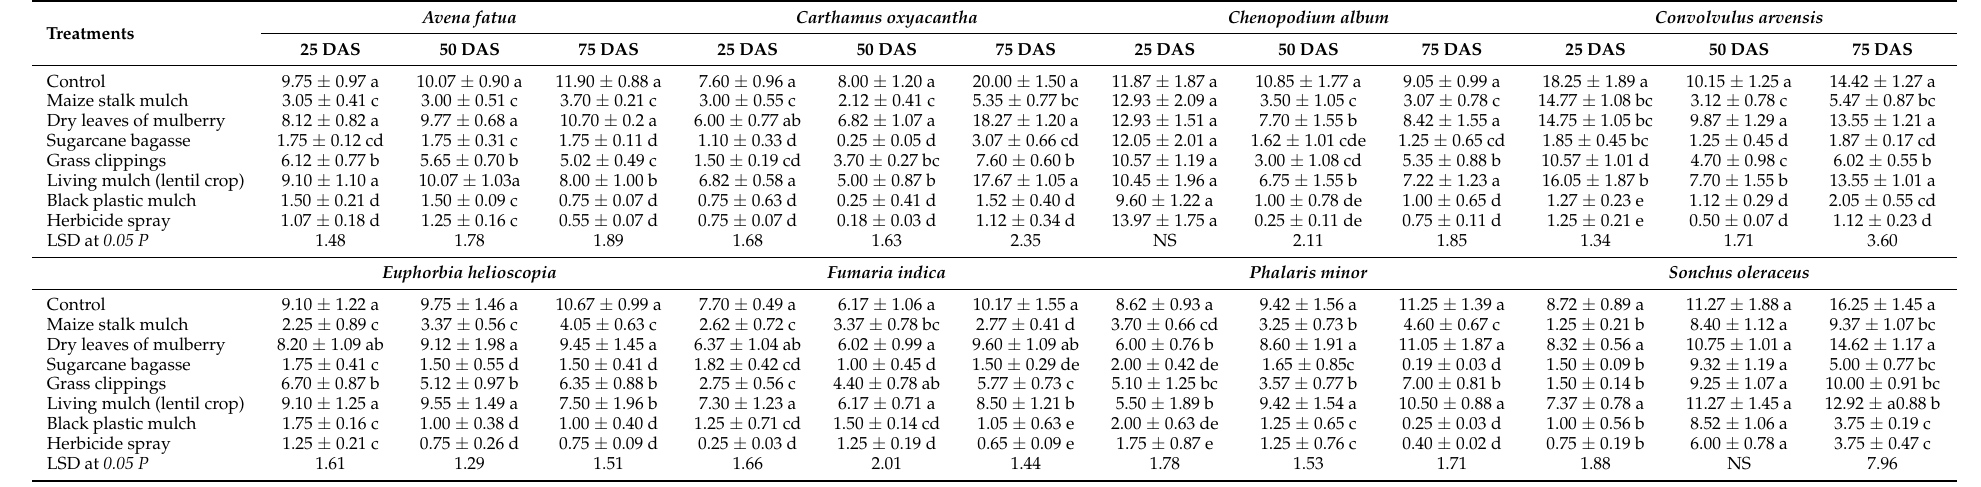
Table 1. Effect of various mulch materials applied on weed density (weeds m − 2 ) of different weed species of